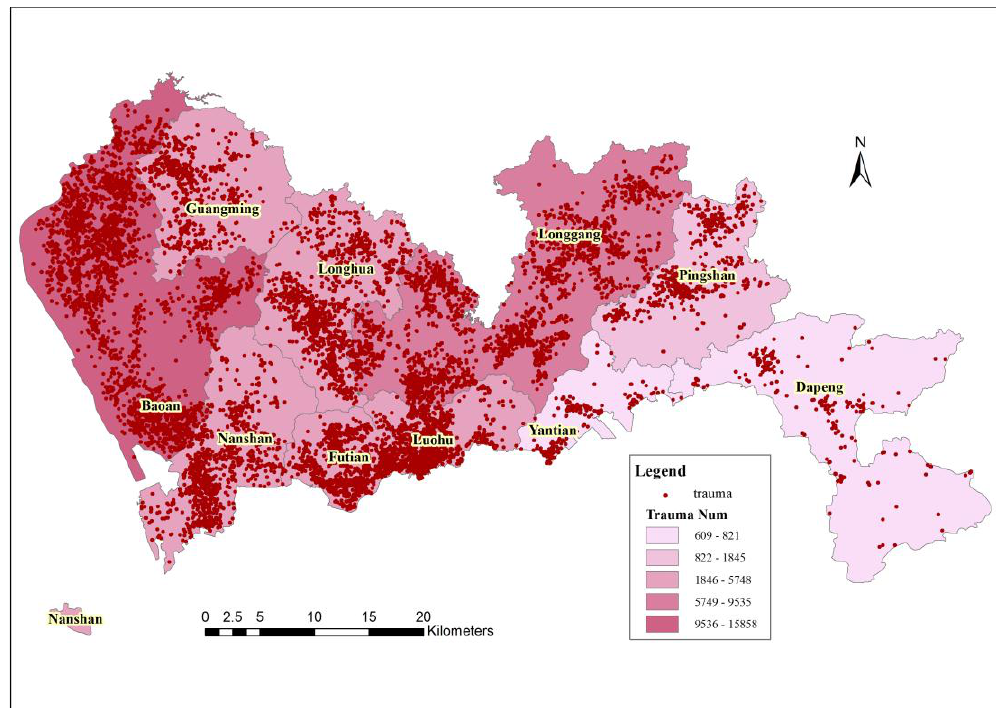
Figure 2. Distribution of trauma occurrences in